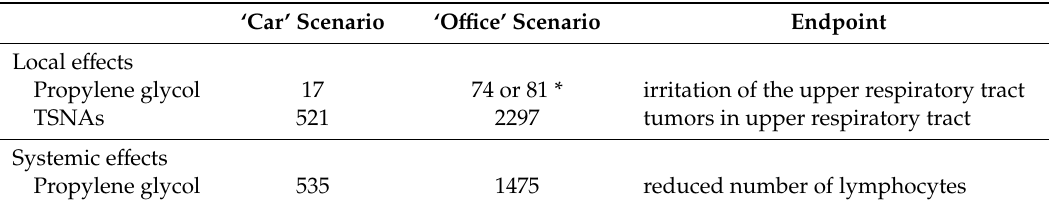
Table 6. Margin of Exposure (MOE) for di ff erent chemicals and scenarios for the evaluation of local and systemic e ff ects, calculated from points of departure (PoDs) and exposure (Supplementary Material 1 and Table 5, respectively). ‘Car’ Scenario ‘O ffi ce’ Scenario Endpoint Local e ff ects Propylene glycol 17 74 or 81 * irritation of the upper respiratory tract TSNAs 521 2297 tumors in upper respiratory tract Systemic e ff ects Propylene glycol 535 1475 reduced number of lymphocytes * PoDs derived from two di ff erent studies (Supplementary Material